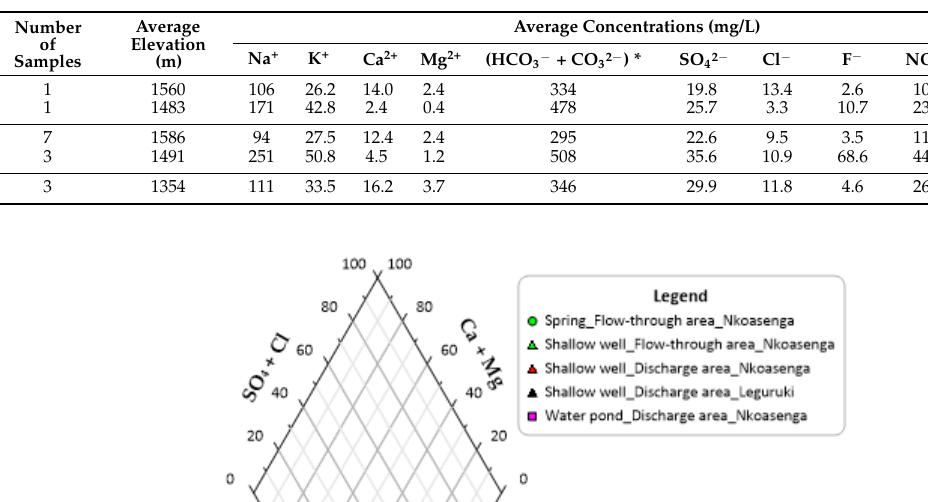
Table 5. Average values of major and minor ions in the water samples from different elevations on the northern flank of Ngurdoto crater (* as mg/L HCO 3 − ).